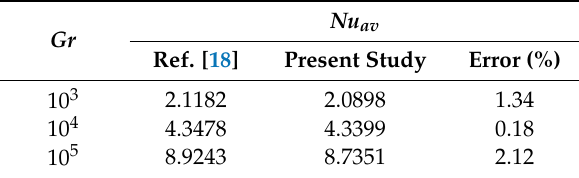
Table 2. Comparison of Nu av with δ = 0.04 with those of Khanafer et al.